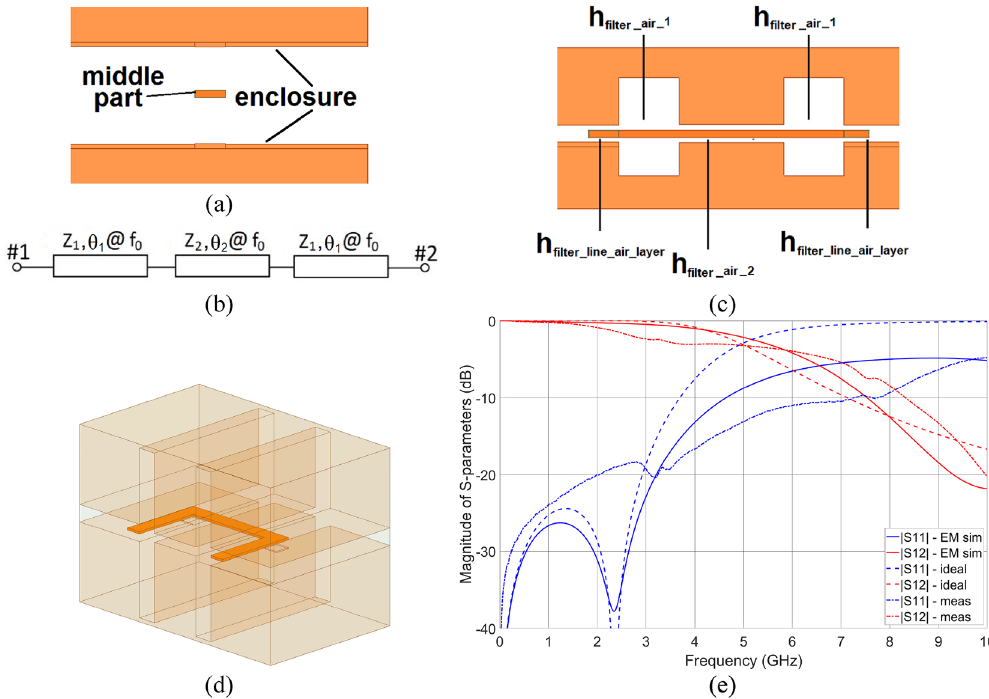
Figure 3. Cross-sectional view—the middle part feature width equal to w filter ( a ). General schematic of a designed step-impedance low-pass filter ( b ). Side view of the designed filter ( c ). The orange color represents the conductive layer. The 3D view of the designed filter ( d ). The EM calculated frequency characteristics in comparison with the ones obtained for ideal transmission line elements and measurement results ( e